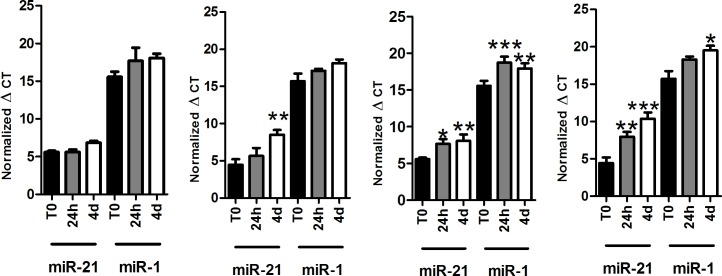
Impact of delayed processing on separated blood fractions.Whole blood was collected into EDTA or serum separator containing tubes and incubated at room temperature for 0h, 24h, and 4 days before processed into plasma (A) and serum (B) or processed into plasma (C) and serum (D) immediately and then incubated at room temperature for 0h, 24h, and 4d. Data presented as normalized average ΔCTvalues±SEM. *p<0.05, **p<0.01, ***p<0.001.